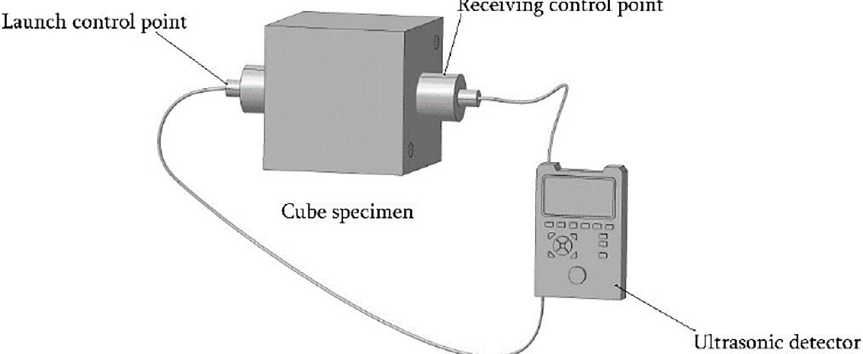
Fig 2. Schematic diagram of the ultrasonic